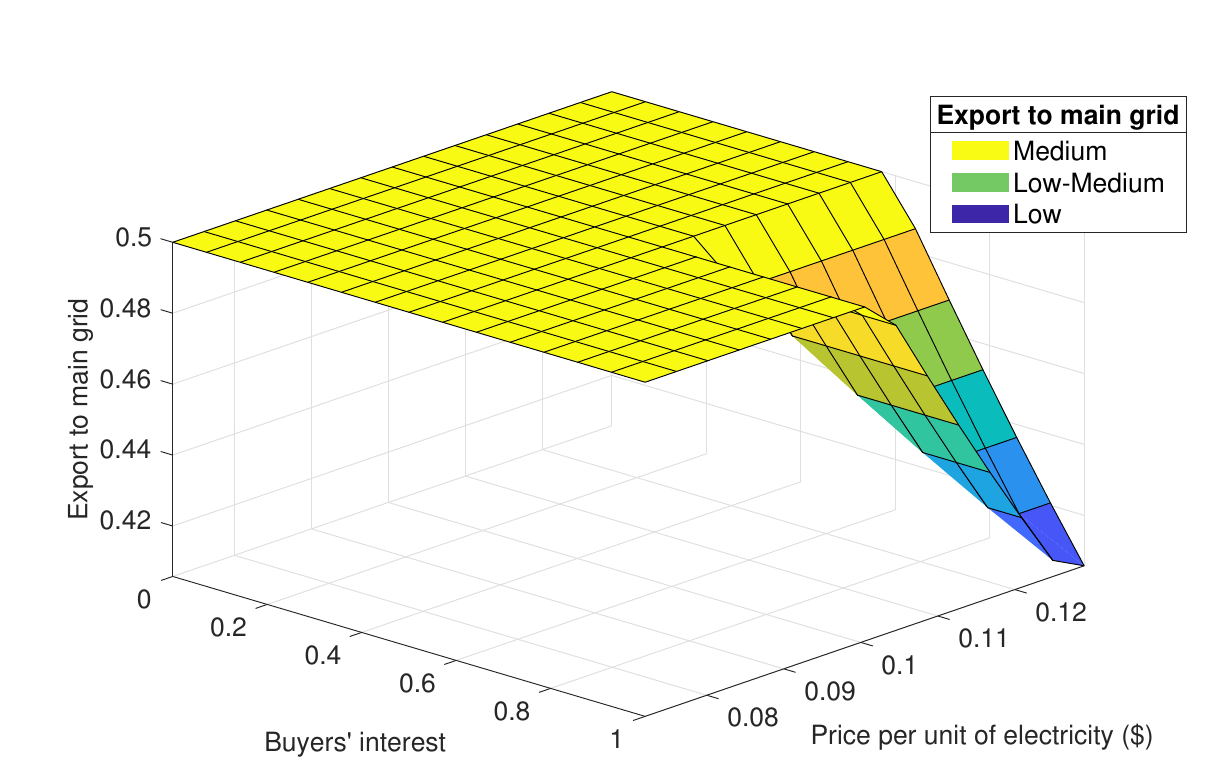
Figure 8. Surface plot of exporting electricity to the main grid, with real-time price per unit of electricity on the X-axis and buyers’ interest on the Y-axis. Other parameters are kept constant for simulation purposes to observe the interrelation of real-time price and buyers’ interest input variables with the exporting of electricity to the main